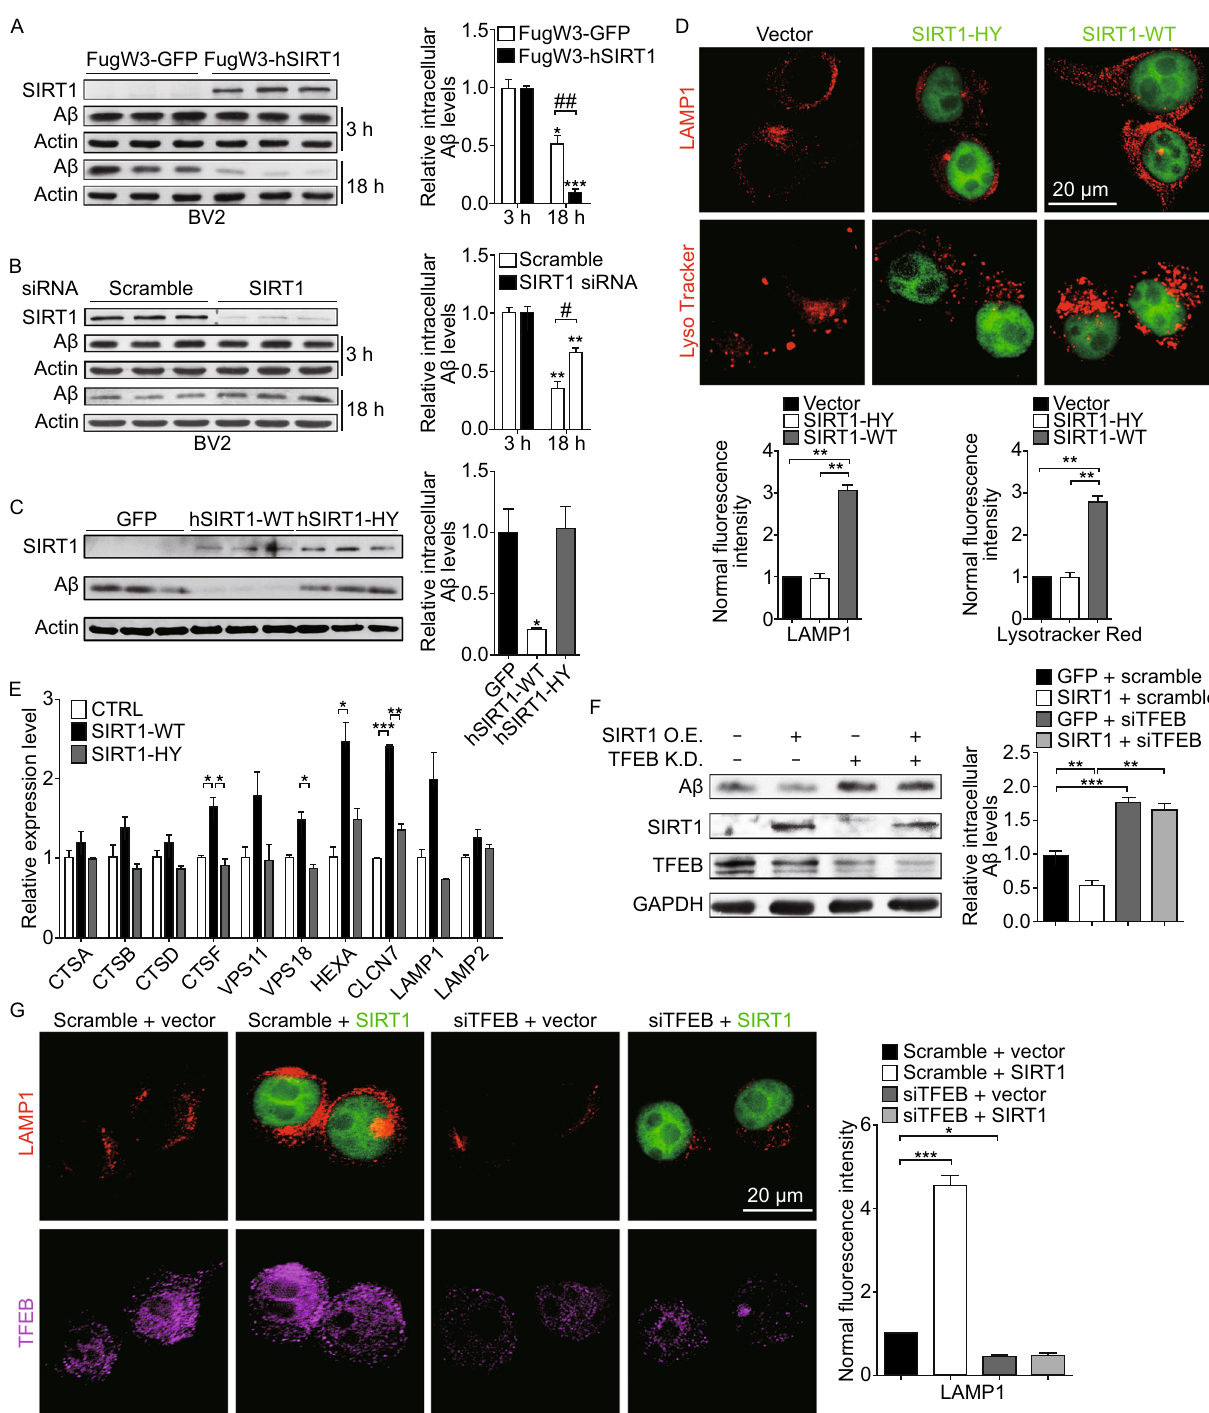
strengthened capability of microglial removal of A β aggre- gates which is triggered by deacetylation of TFEB. According to our results, deacetylation of TFEB, carried out by its deacetylase SIRT1, promotes microglial degradation of fA β and amyloid plaques by upregulating lysosomal function and